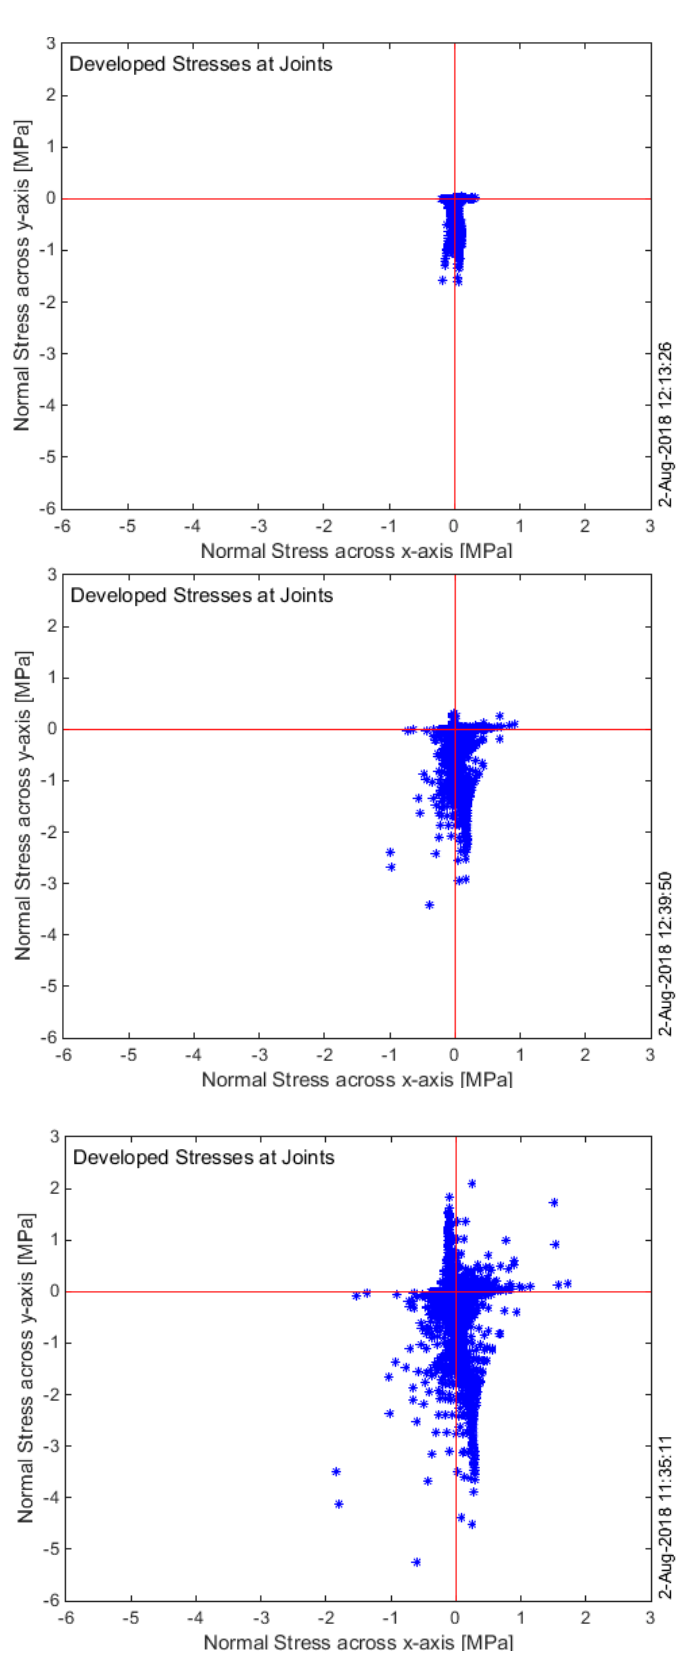
Figure 34. Evolution of the developing normal stresses for values of PGA ranging from 0.00 to 0.40 g by step 0.20 g.